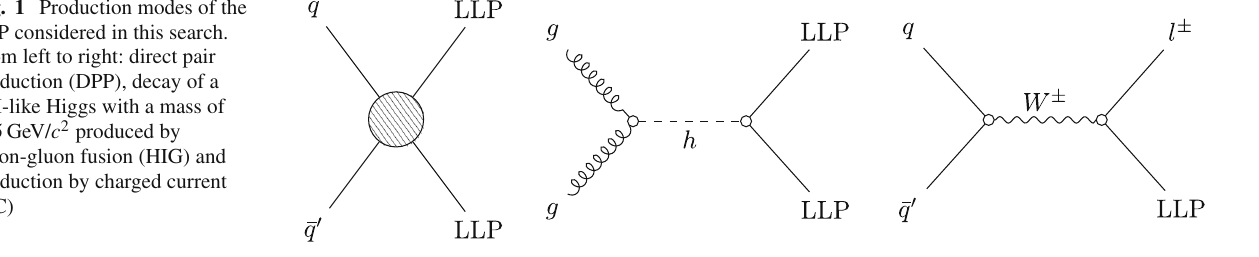
(PV), the impact parameter (IP), is measured with a resolu- tion of ( 15 + 29 / p T ) µ m, where p T is the component of